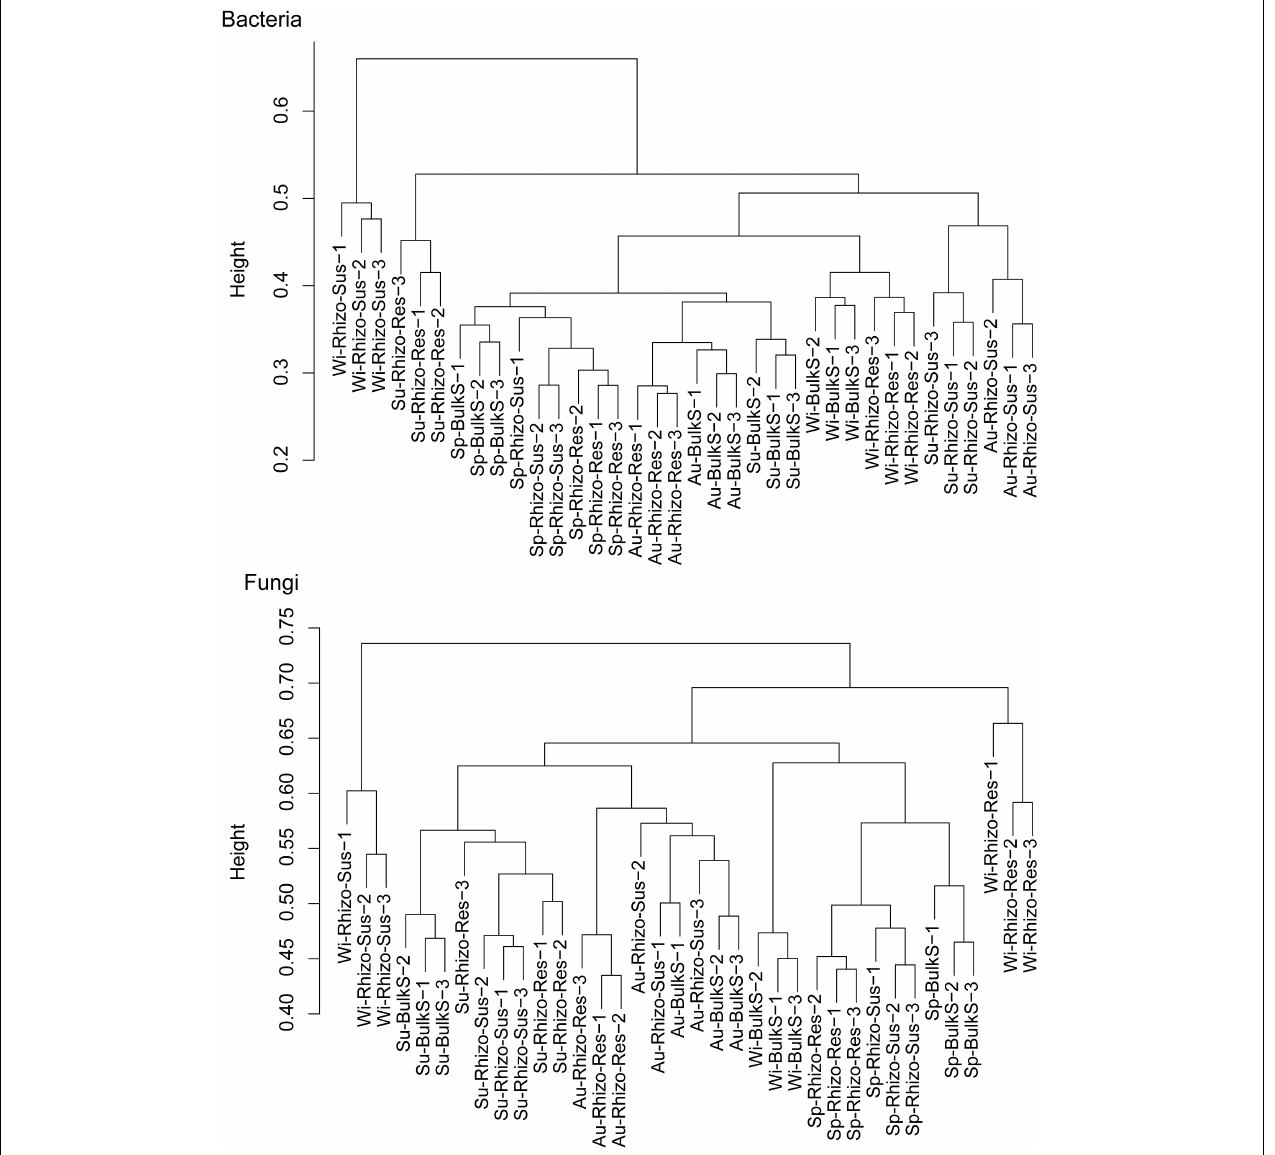
FIGURE 2 | Cluster dendrogram of bacterial and fungal communities based on unweighted uniFrac distance. Sp, Su, Au, and Wi indicates spring, summer, autumn, and winter, respectively. Rhizo-Sus, Rhizo-Res, and BulkS indicate disease-susceptible C. oleifera rhizosphere, disease-resistant C. yuhsienensis rhizosphere, and bulk soil, respectively, N = 3. Height in cluster dendrogram indicates the distance of microbial communities among each